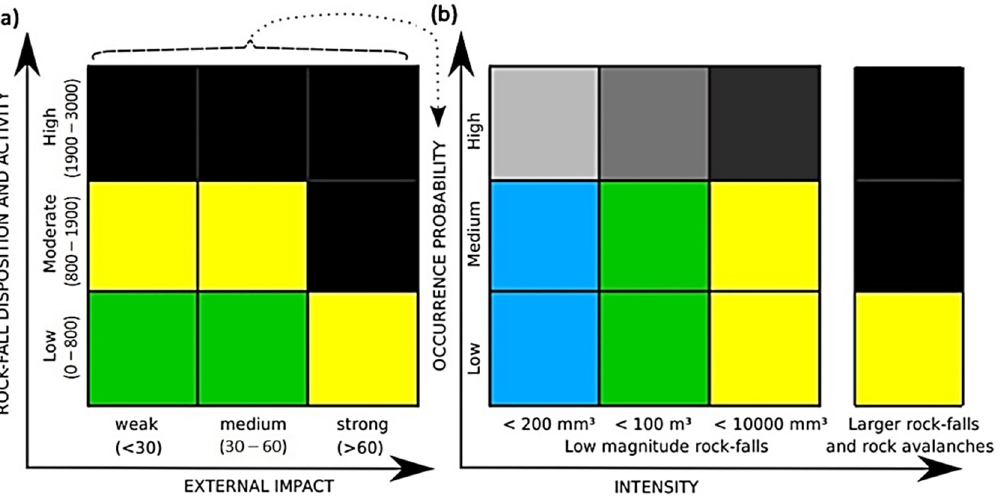
Figure 2. ( a ) Probability Matrix: green, “low”; yellow, “medium”; and black, “high”. ( b ) Hazard Matrix: blue, very low hazard; green, low; yellow, medium; gray (with grayscale), high, modified from [8].